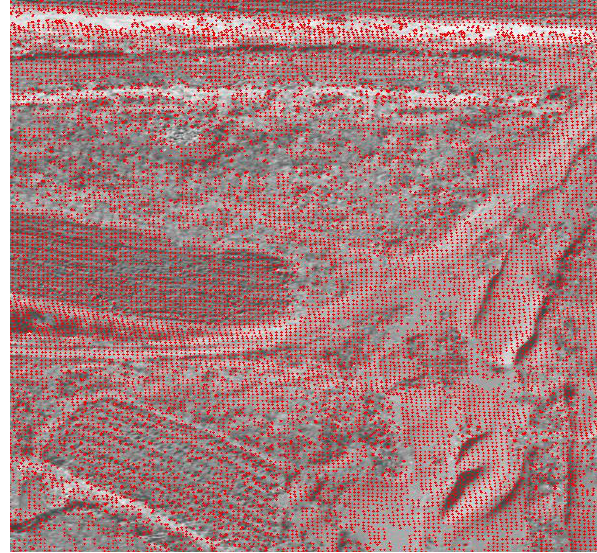
Figure 2. POS-supported dense matching